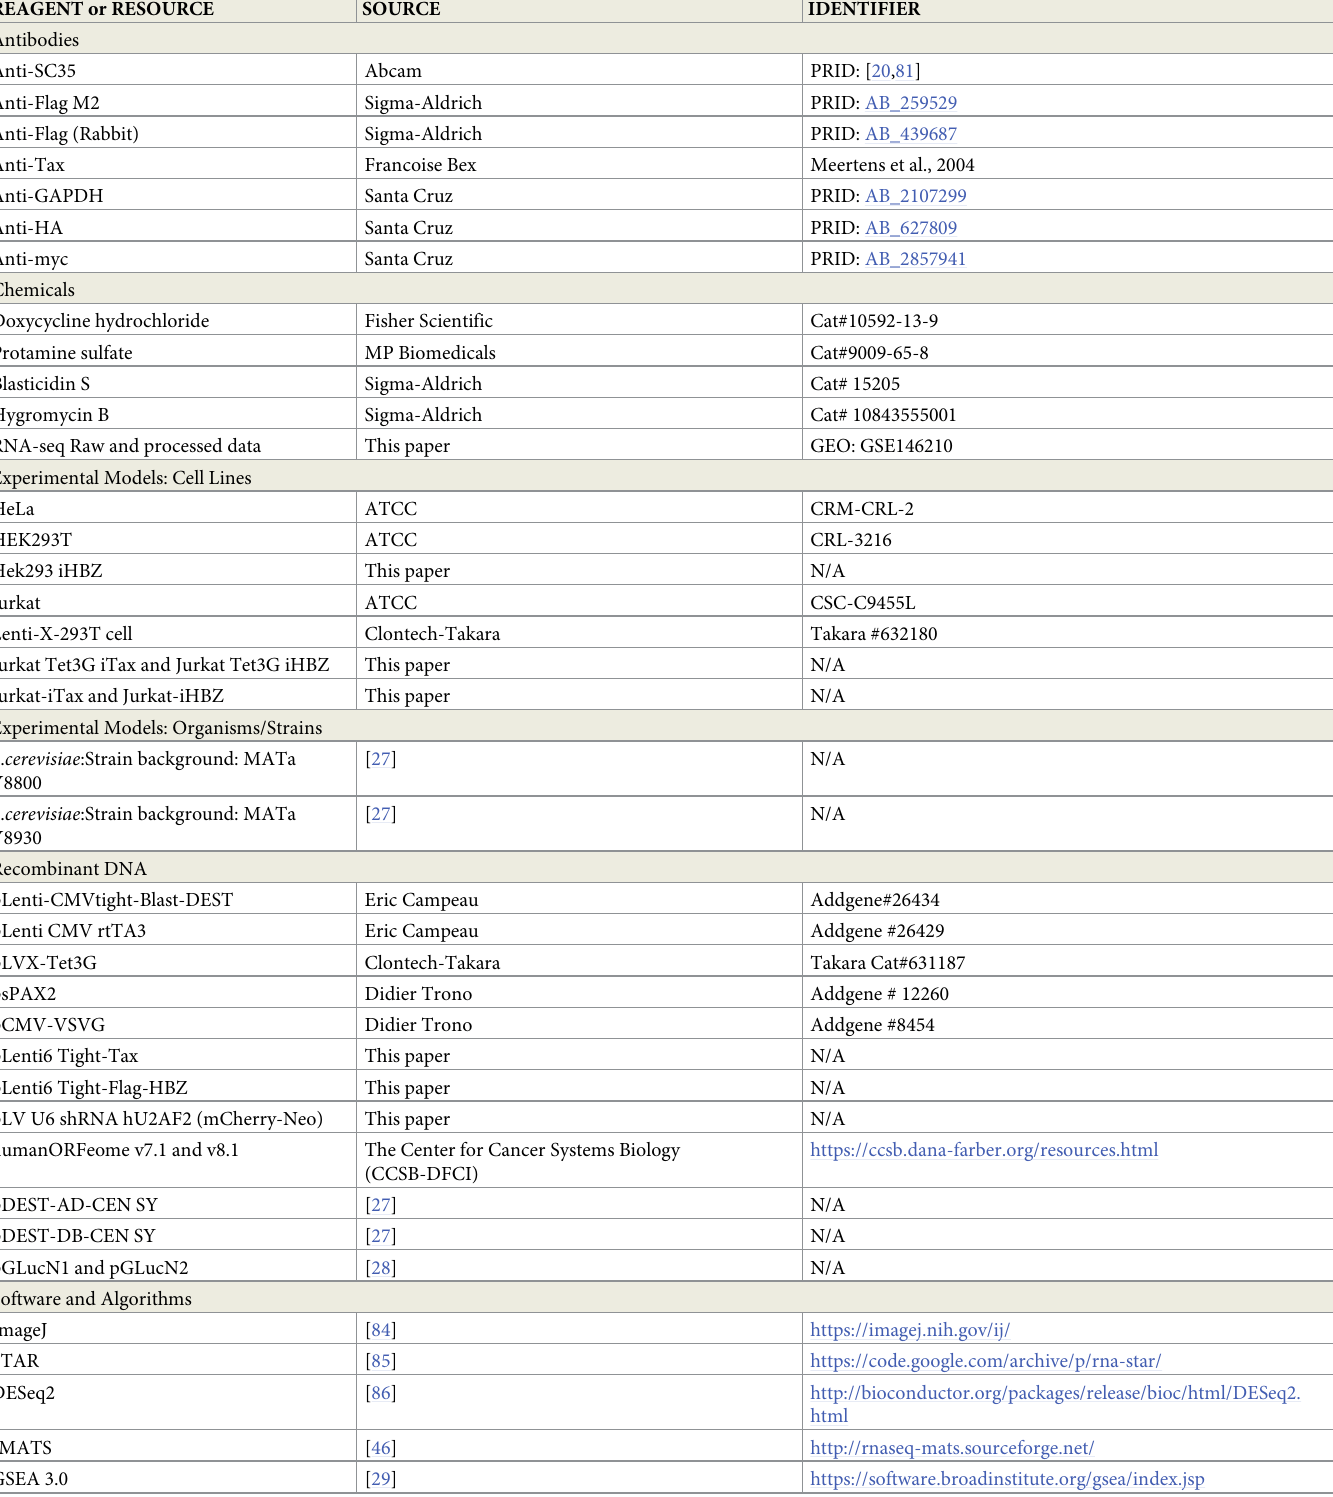
Table 1. Reagents and tools used in this study. Reagents and tools are indicated with their source and